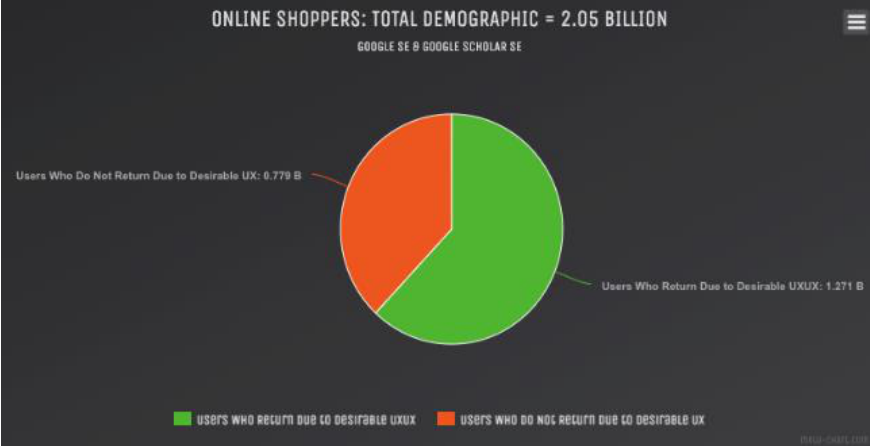
Figure 1: E-Commerce user's Reaction to Bad